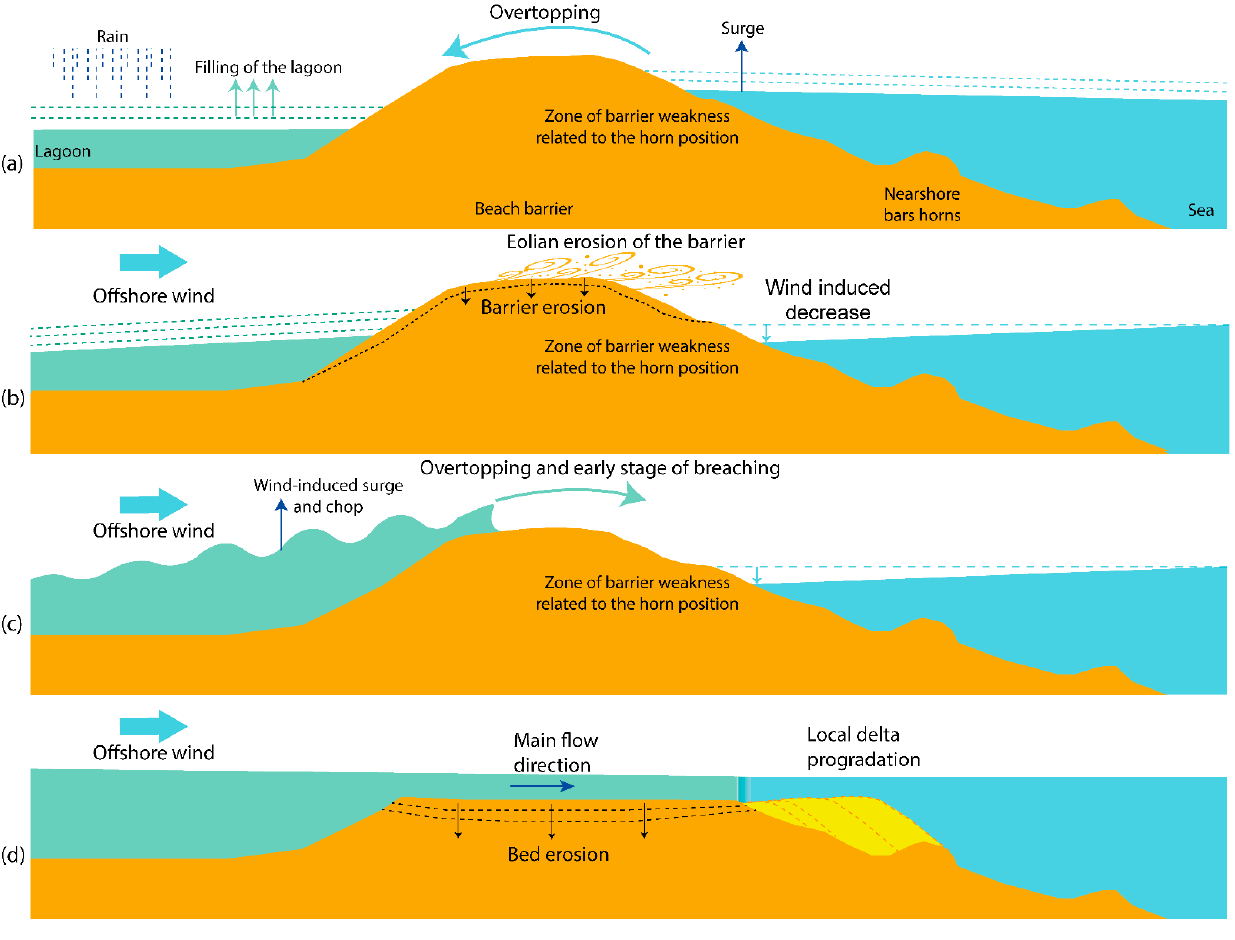
Figure 12. Sectional diagram of the opening mechanisms during periods of strong offshore wind; ( a ) pre ‐ conditioning of the barrier due to filling of the lagoon by precipitation and overtopping by waves; ( b ) Beach barrier erosion and reduction of beach height due to offshore wind erosion; ( c ) Barrier breaching due to lagoon water overtopping and lowering of berm zone due to connection of nearshore bars at the level of beach megacusp horns, associated with local progradation; ( d ) Opening of the inlet, with bed erosion by currents and deposition of a delta at the outlet.